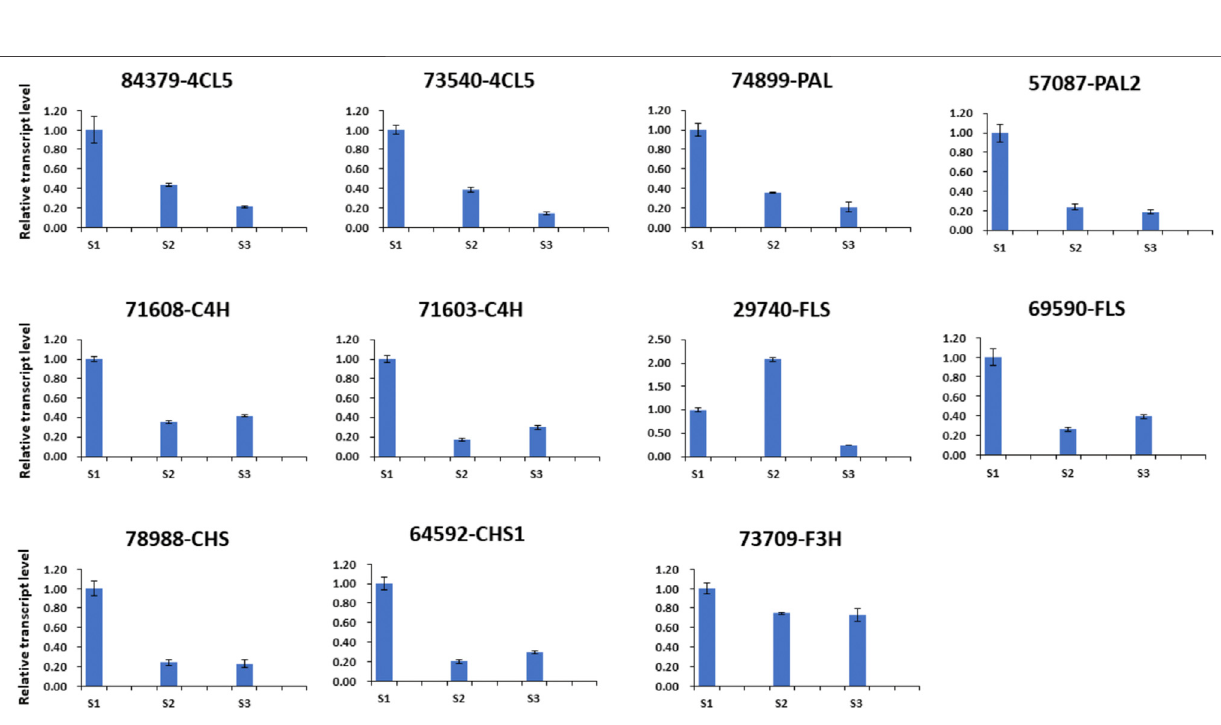
Frontiers in Genetics |